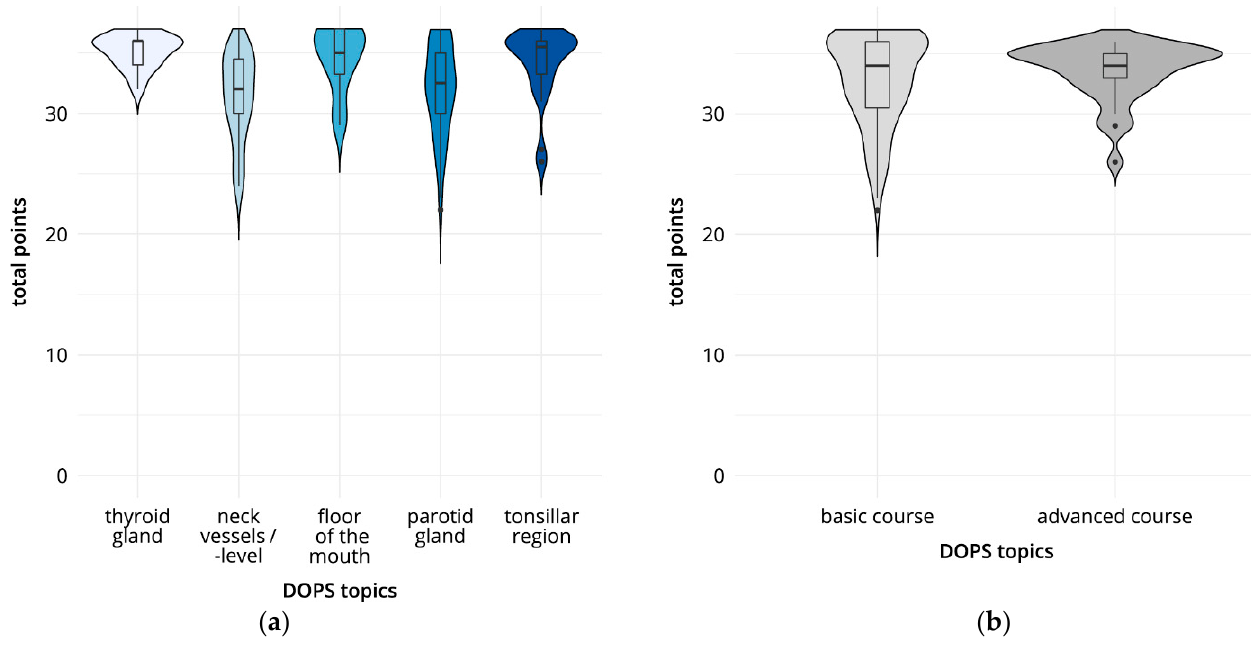
Figure 4. Direct observation of procedural skills (DOPS) tests: results comparing total points ( a ) and course format ( b ). ( a ) Total points for the five DOPS tests. ( b ) Total points in the basic and advanced course formats.